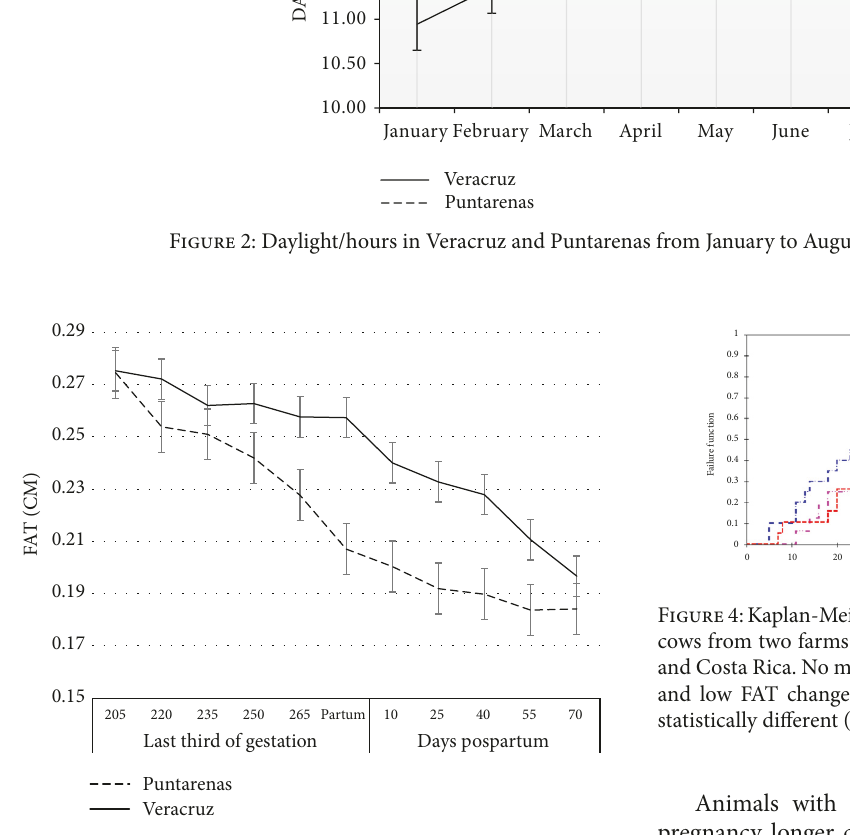
Figure 3: Back fat thickness in all cows, specifically in Veracruz and Puntarenas cows (error bars are presented).